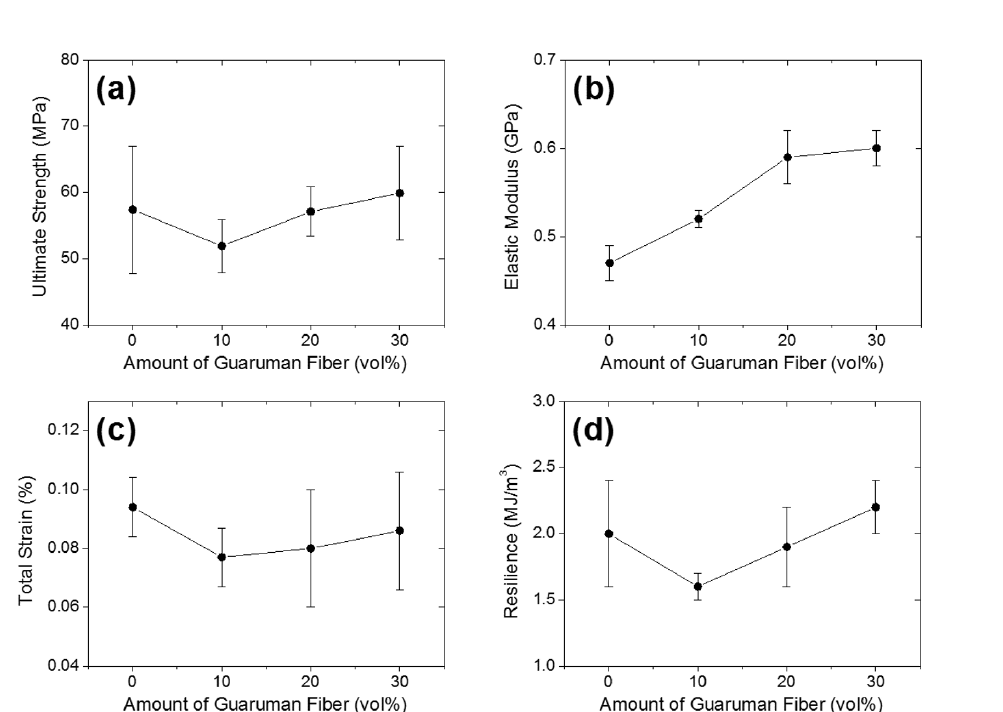
Figure 6. Variation with amount of guaruman fiber as reinforcement of epoxy composites of (a) ultimate strength; (b) elastic modulus; (c) total strain; and (d) resilience.